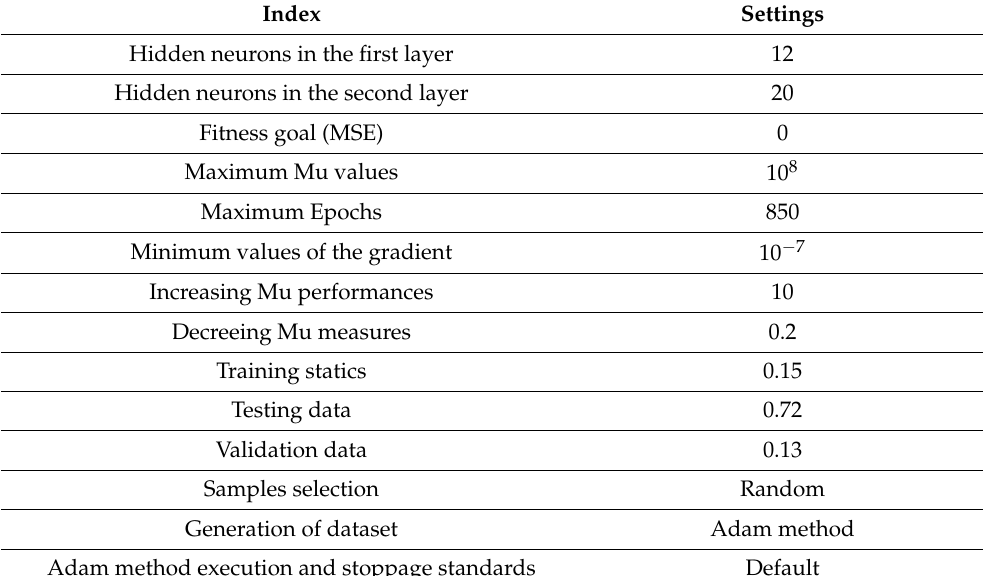
Table 1. Parameter adjustment for the SCGNNs approach.